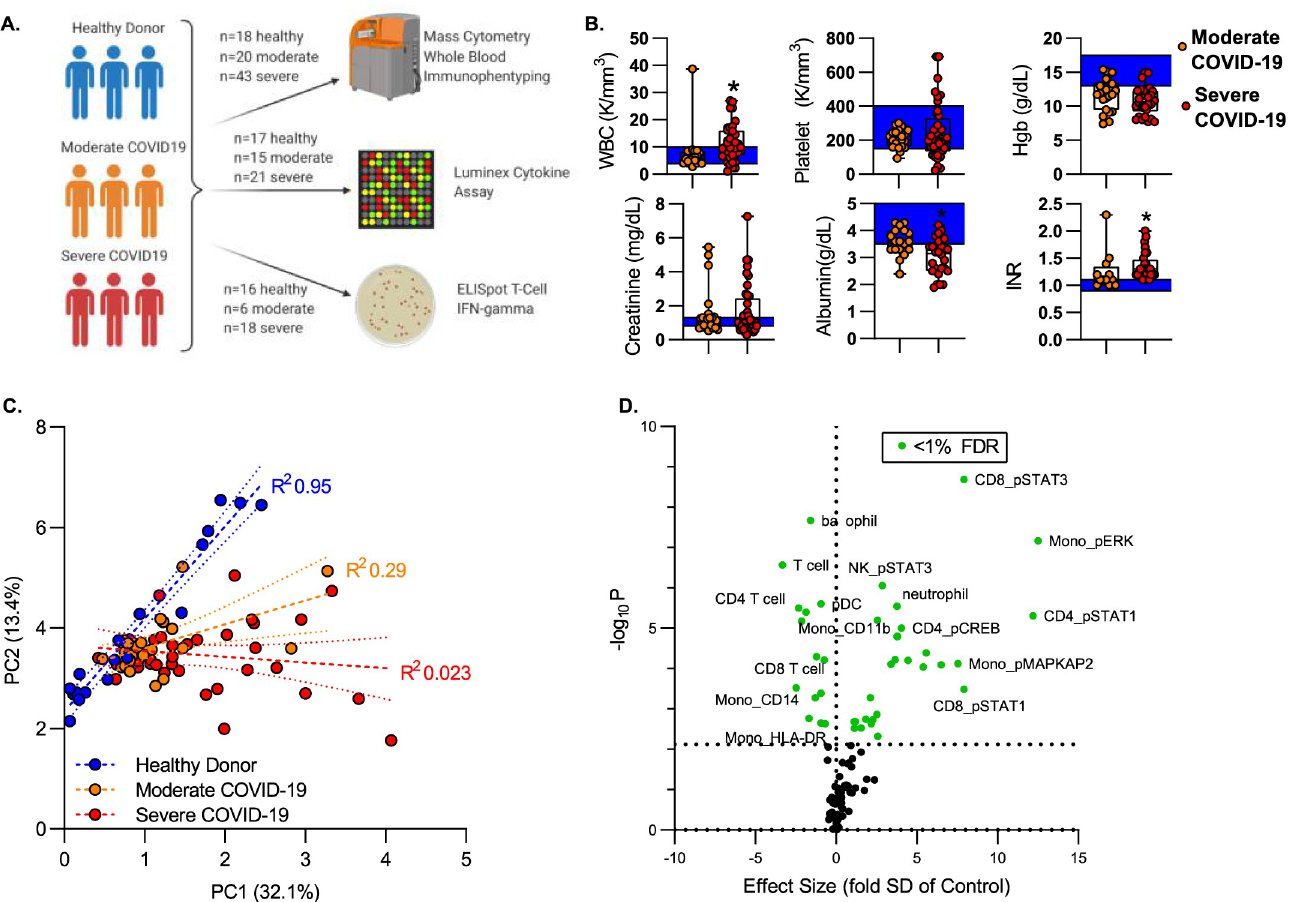
Fig 1. Mass cytometry to define the molecular mechanisms of COVID-19. A) Study overview. Peripheral blood was isolated from healthy donors or patients with COVID-19. All subjects were recruited within 72 hours of hospital admission. “Moderate” was defined as acute illness requiring hospitalization; “Severe” as subjects with critical illness requiring ICU care. Whole blood was fixed and stored for batch CyTOF analysis. Plasma was stored for soluble marker analysis. Peripheral blood mononuclear cells were isolated by density gradient centrifugation for T cell function assay by ELISpot. B) Clinical laboratory values of patients with COVID-19. Box plots represent 25-75 th percentile with line defining group median, with all data-points overlying. Error bars extend from minimum to maximum values. Shaded area represents the normal value reference range. � p < 0.05, �� p < 0.01, ��� p < 0.001, ���� p < 0.0001 vs moderate COVID-19 by Mann- Whitney U test. C) Principal Component Analysis of 95 cellular featured define by CyTOF. Dashed lines represent linear regression line of the first two principal components for each cohort (healthy, moderate COVID, severe COVID); dotted lines show the 95% confidence intervals. D) Volcano plot of features defined by CyTOF. Effect size defined as difference of means between severe COVID vs. healthy, divided by standard deviation of healthy. P-value was measured by nonparametric (Kruskal-Wallis) ANOVA across cohorts. Significance defined as false discovery rate (FDR) < 1% by Benjamini, Krieger and Yekutieli FDR < 1% = p < 0.0058 (dotted line). Features that vary significantly across groups shown in